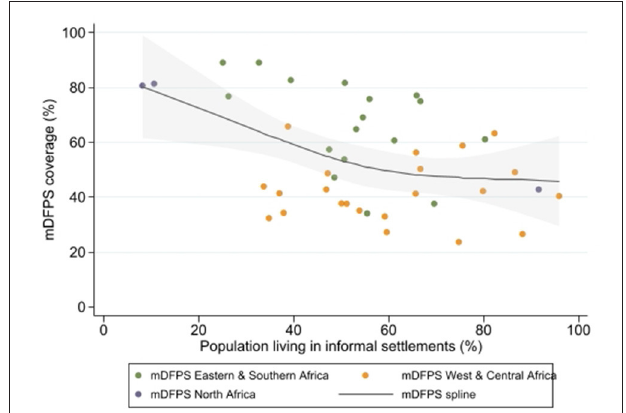
FIGURE 2 | Cubic spline model showing the relationship between the coverage of demand for family planning satisfied by modern methods and the proportion of the population living in informal settlements for each region.